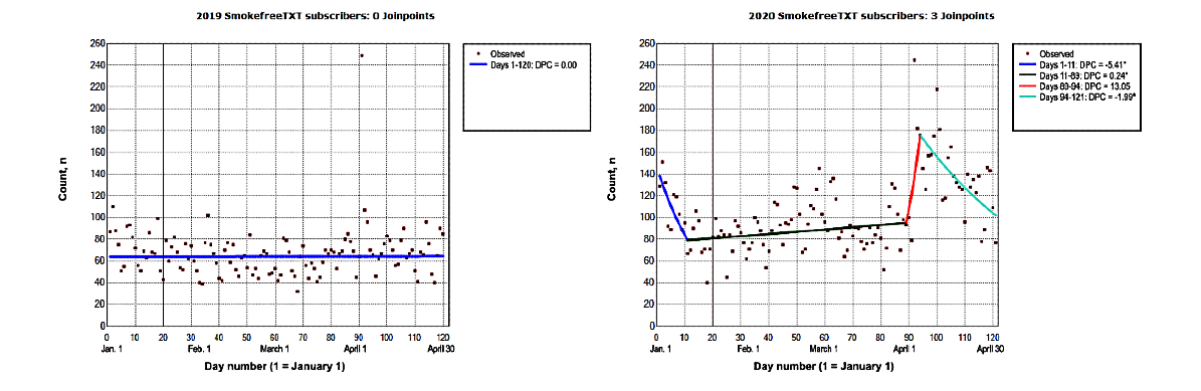
Figure 5. The number of new SmokeFreeTXT subscribers from January to April 2019 and 2020. The vertical line represents January 20. On this day in 2020, the first laboratory-confirmed COVID-19 case was identified in the United States. This was reported to the Centers for Disease Control and Prevention on January 22, 2020 [43]. Data on model selection appear in Multimedia Appendix 1. DPC: daily percent change. *The DPC is significantly different from 0 at an α level of